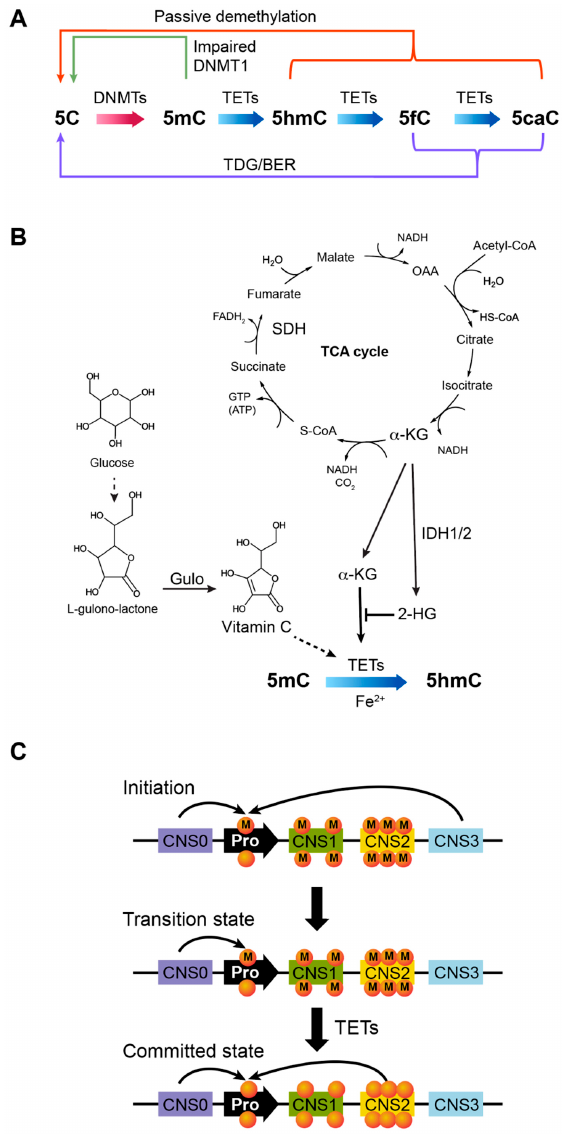
Figure 4. DNA demethylation by TET enzymes stabilizes Foxp3 transcription. ( A ) Schematic of the processes of TET-dependent DNA demethylation. TET enzymes catalyze sequential oxidization of